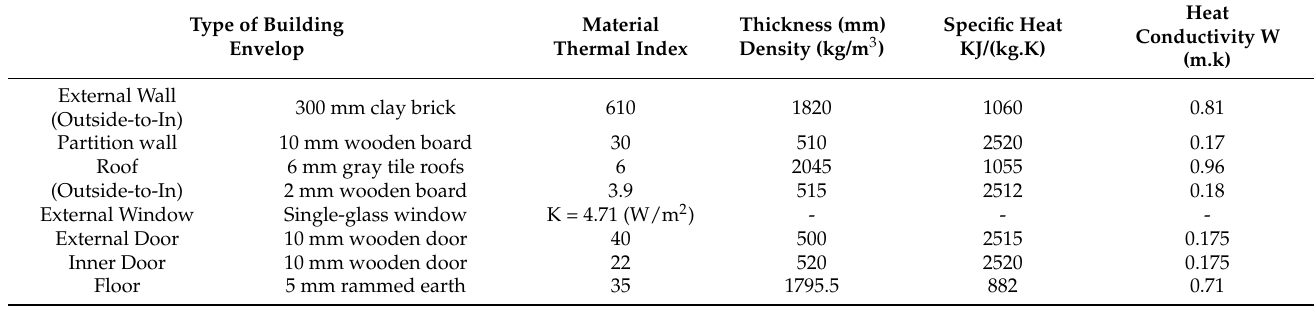
Table 5. Material settings of the traditional dwelling envelope.